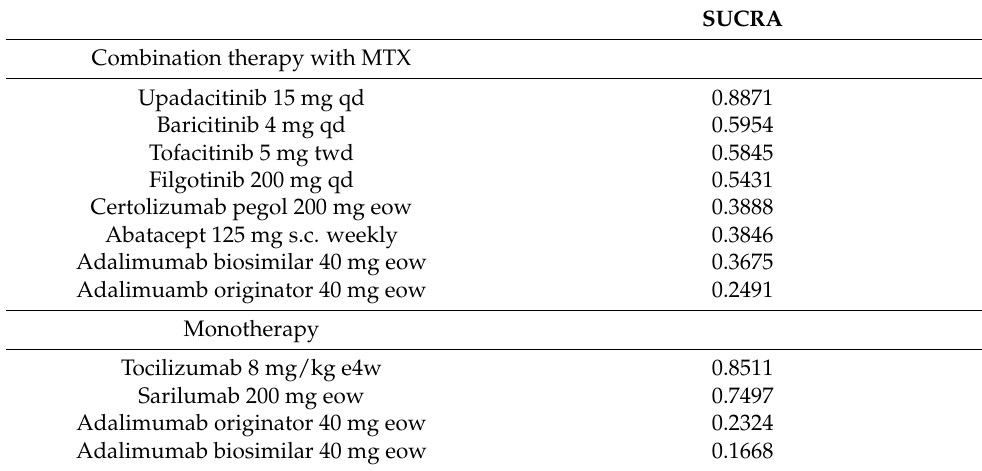
Table 2. Rank probability of biologics and target synthetic DMARDS in terms of efficacy based on the number of patients who achieved an American College of Rheumatology 50 response rate as combination therapy with methotrexate or as monotherapy (SUCRA—Surface Under the Cumulative RAnking curve).